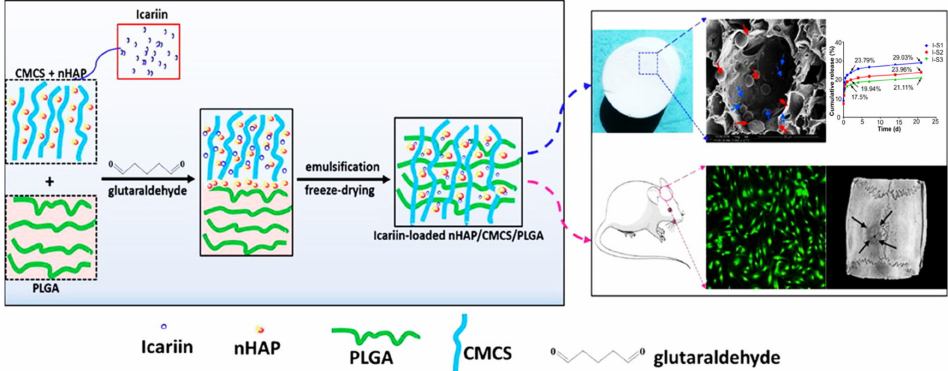
Figure 4. The preparation process of icariin-loaded HAP/CMCS/PLGA scaffolds and the application for cranial defects repair Reprinted with permission from ref. [123]. Copyright 2020 Chem. Eng.